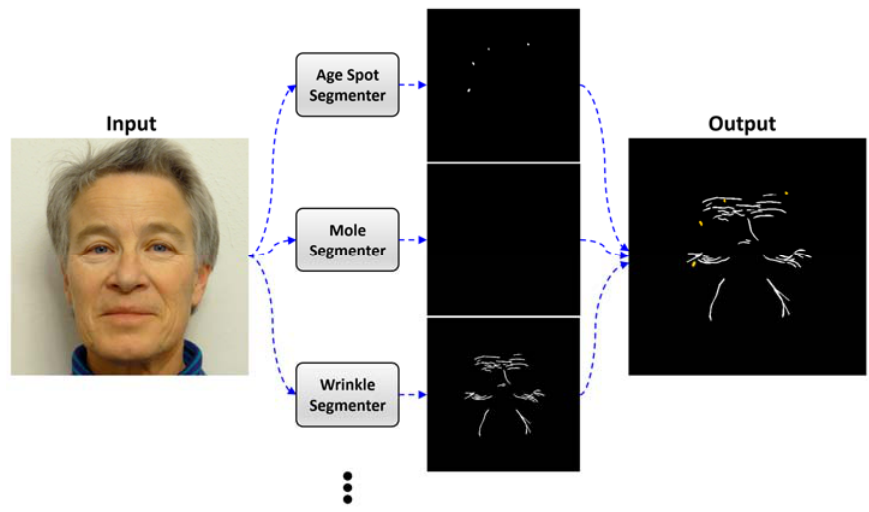
Figure 8. Applying k segmentation models and integrating the results of all segmentations.